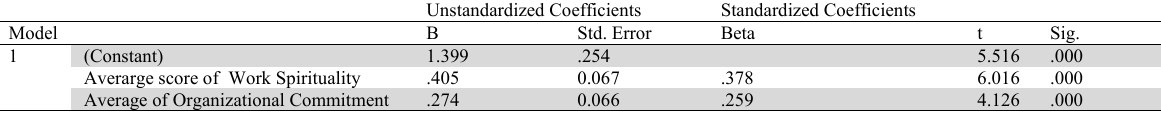
Coefficients between WS, OC, and WE